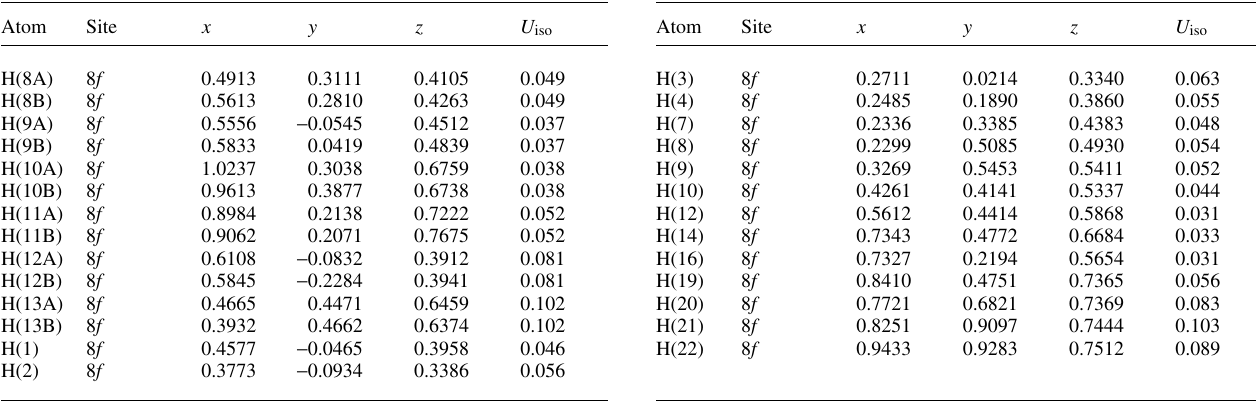
Table 2. Atomic coordinates and displacement parameters (in Å 2 )